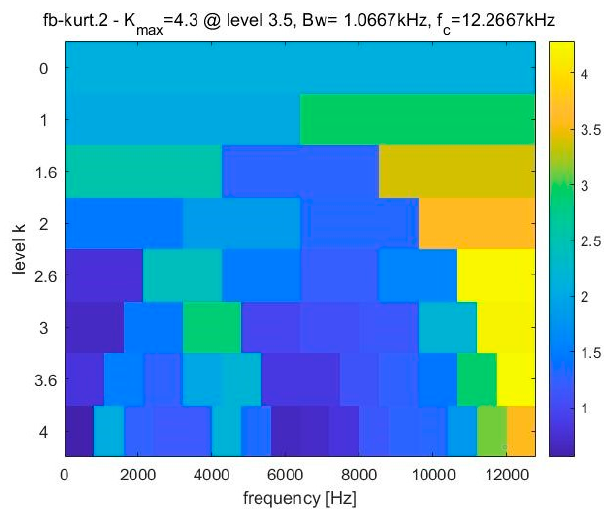
Figure 11. Fast Spectral Kurtosis Map.